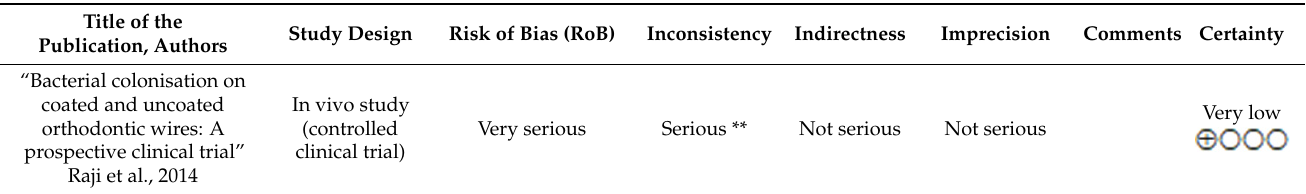
Table 4. The GRADE analysis for in vivo studies.